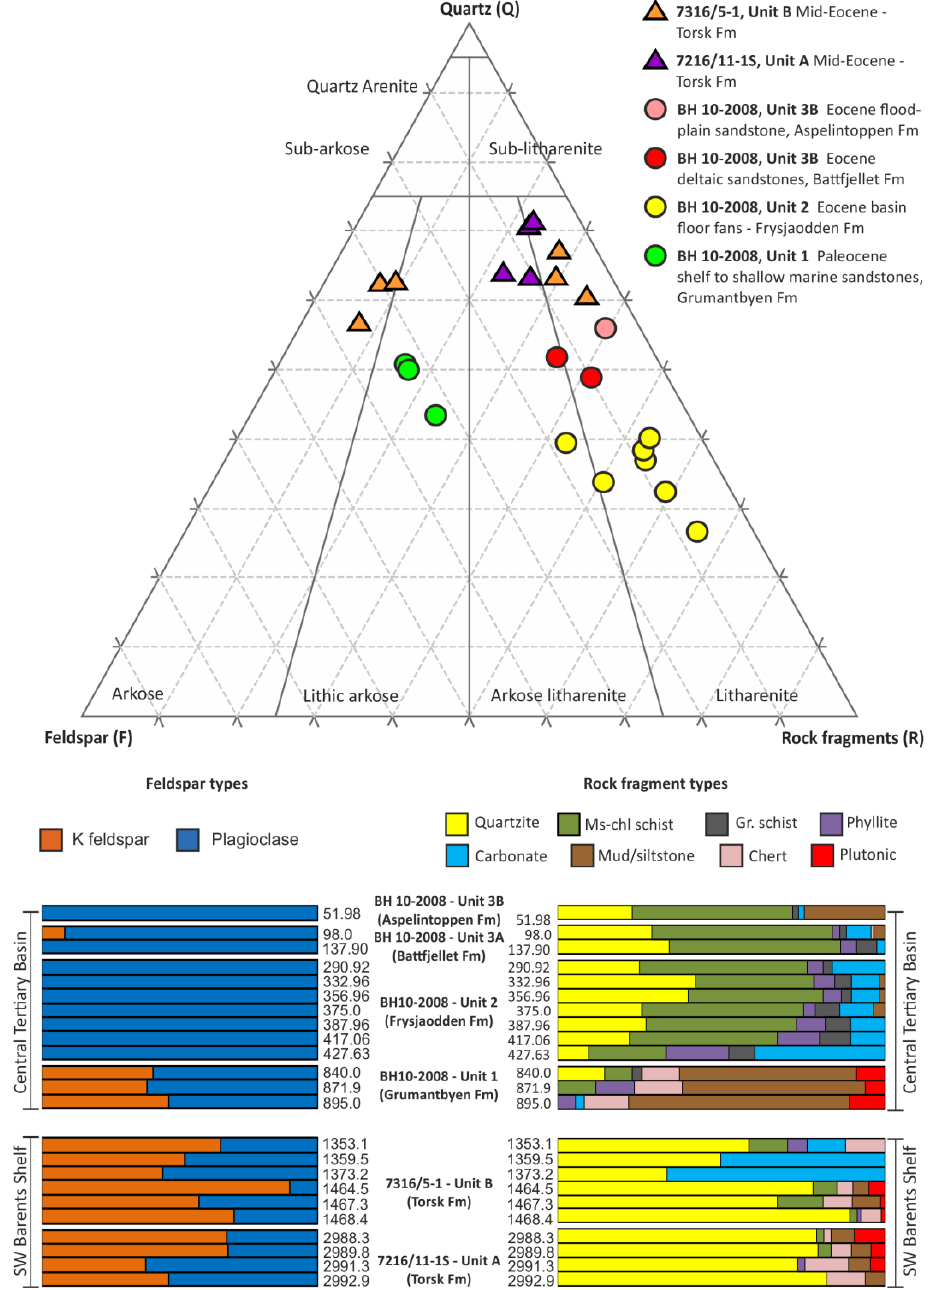
Figure 3. QFR ternary diagram after Folk, Andrews and Lewis [53] determined from petrography on the investigated samples. Feldspar type and rock fragment type proportions are illustrated by the normalised bar charts where Ms-chl schist = Muscovite-chlorite schist and Gr. Schist = Graphitic schist.